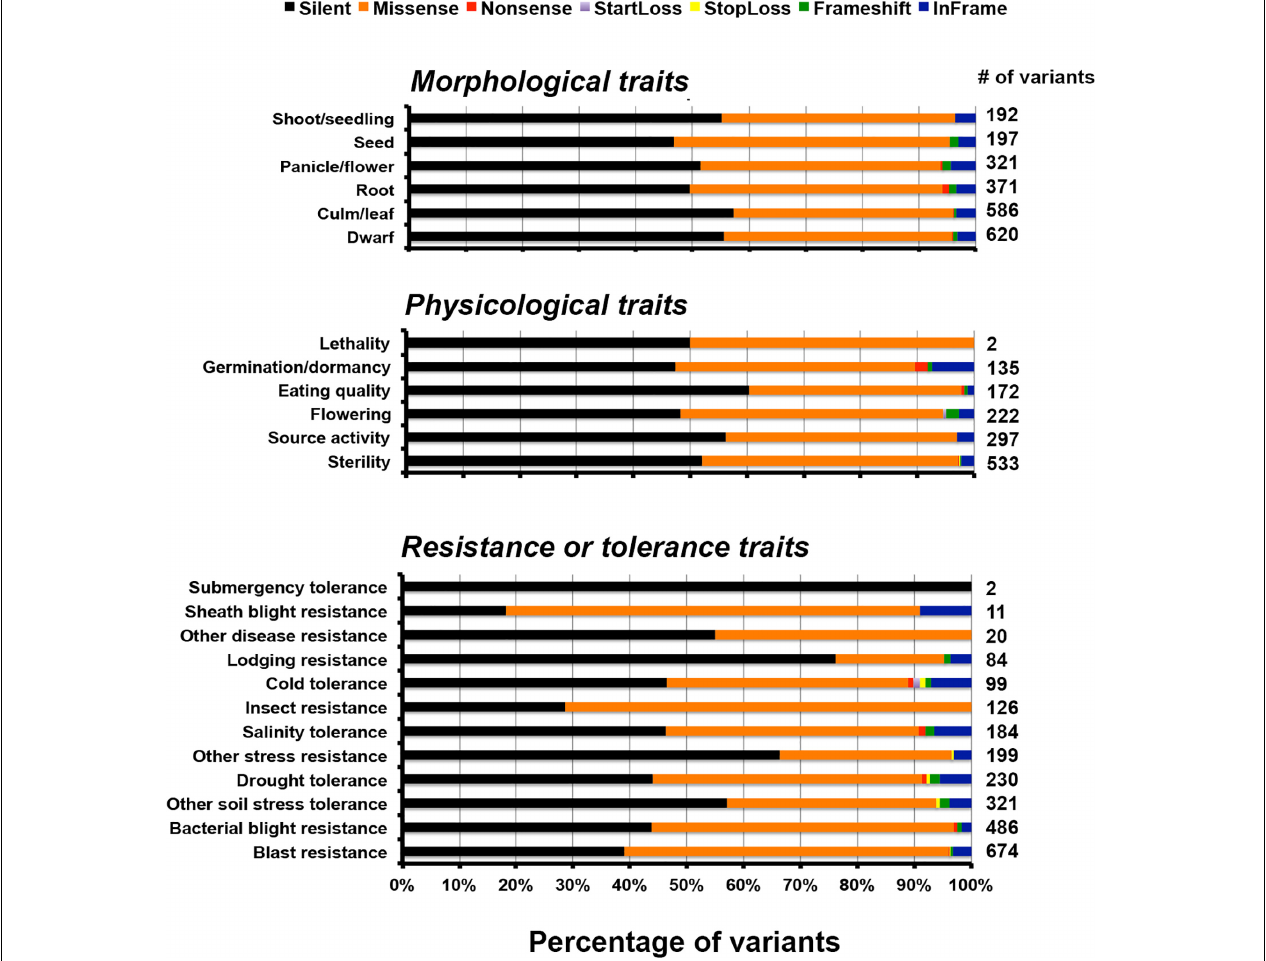
FIGURE 5 | Bar diagram showing total number of different variants involved in morphological, physiological traits, and resistance to biotic and abiotic